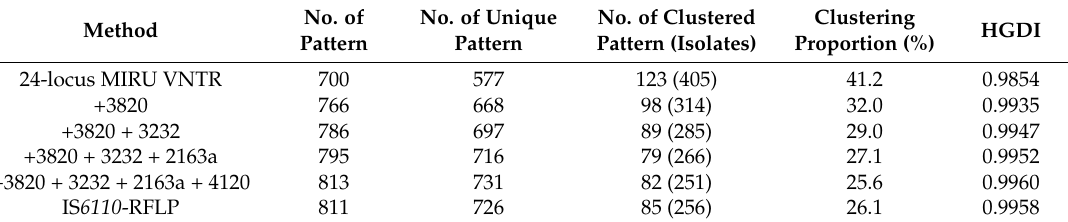
Table 3. Comparison of technical validation in different genotyping